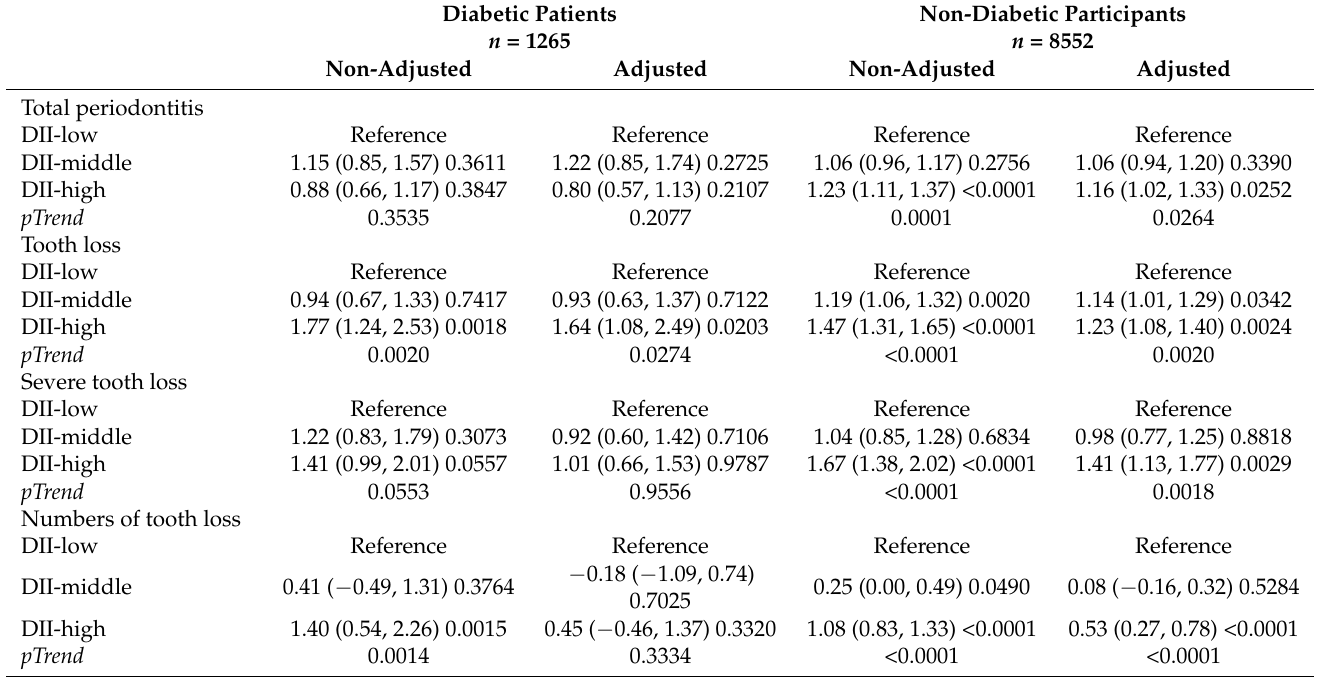
Table 4. Multi-regression analysis of DII on periodontal outcomes stratified according to